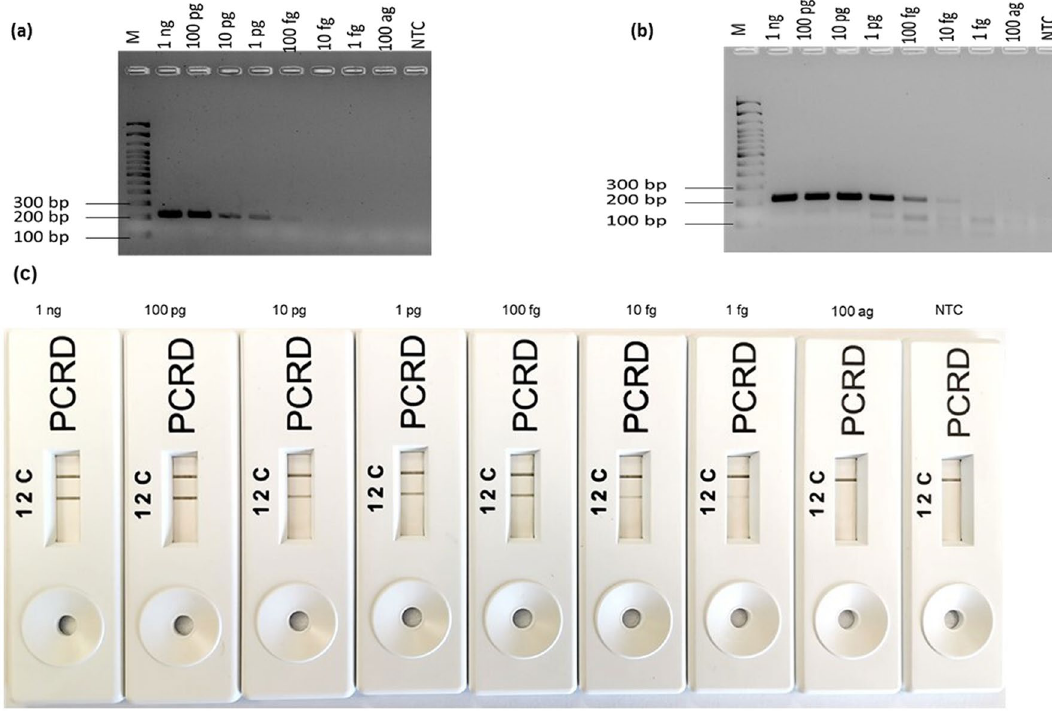
Figure 3. Sensitivity evaluation of RPA-LFA (by using rfbE F1/R1) to detect various DNA concentrations of E. coli O157:H7. From left to right 1 ng to 100 ag and non-template control (NTC). ( a ) By PCR-AGE, ( b ) by RPA- AGE assay, ( c ) by RPA-LFA.